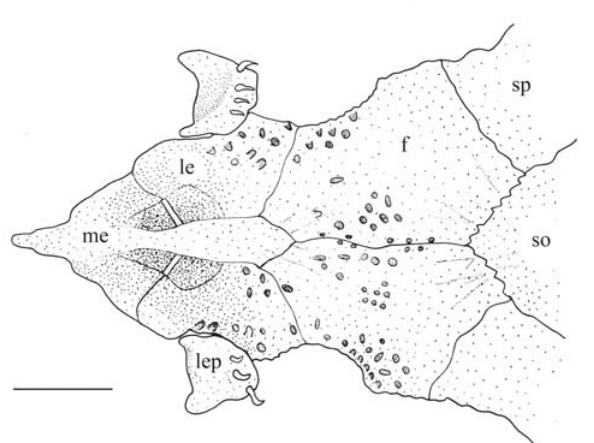
Fig. 3. Partial cranial osteology of Scoloplax baskini , INPA 28650, paratype, 16.1 mm SL, anterior toward left. Rostral plate removed. f = frontal; me = mesethmoid; le = lateral ethmoid; lep = lateral ethmoid plate; so = supraoccipital; sp = sphe- notic. Scale = 0.5 mm.